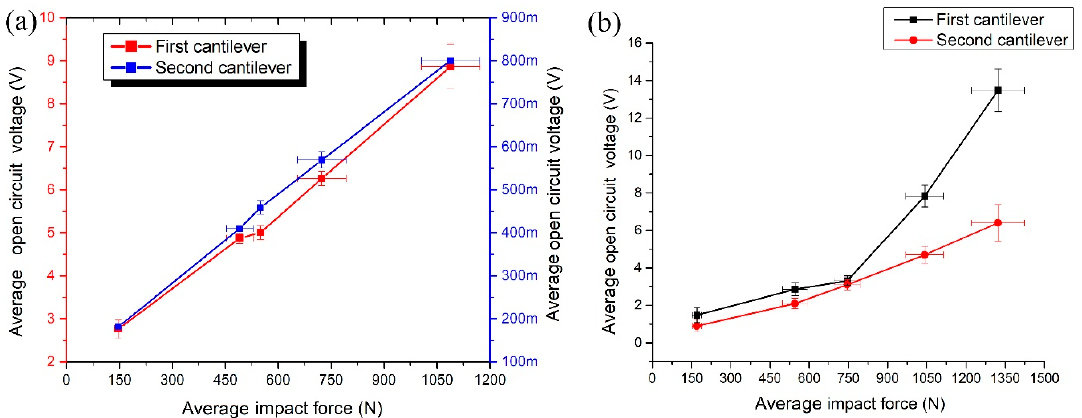
Figure 18. Measured open circuit voltage versus impact force when force direction is aligned with y axis ( a ) and z axis ( b ).